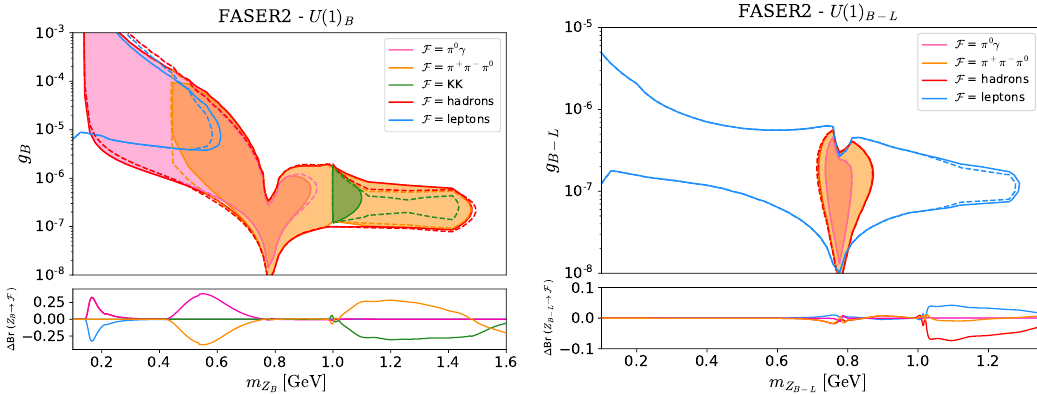
Figure 12 . Expected sensitivity for the B (left panel) and B − L (right panel) models for FASER2 using our calculations for the branching fractions implemented in the FORESEE code. The various final state contributions are highlighted by different colors as in figure 7: πγ (pink), 3 π (orange), KK (green) and leptons (blue). The dashed lines, using the same color scheme, show the results using the FORESEE code and DarkCast branching ratios. In the bottom panels we also show for each model the difference of the branching ratio between our calculation and DarkCast